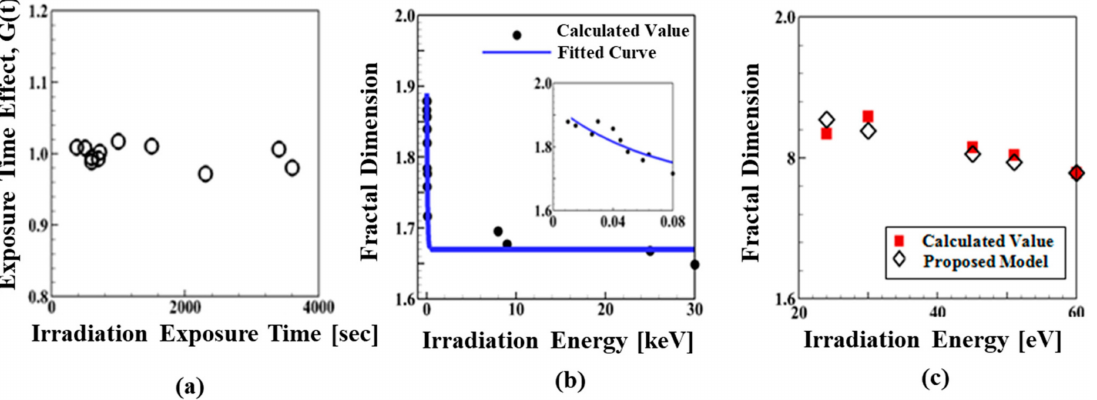
Figure 2. ( a ) The influence of irradiation exposure time on the fractal dimension of the examined W microstructures (See the text for details). ( b ) Fractal dimension evolution as a function of irradiation energy. ( c ) A comparison of the calculated values with the predictions from the proposed relation of fractal dimension of the irradiated W microstructures. Microscopic images in ([24,26,28–33]) are used for the